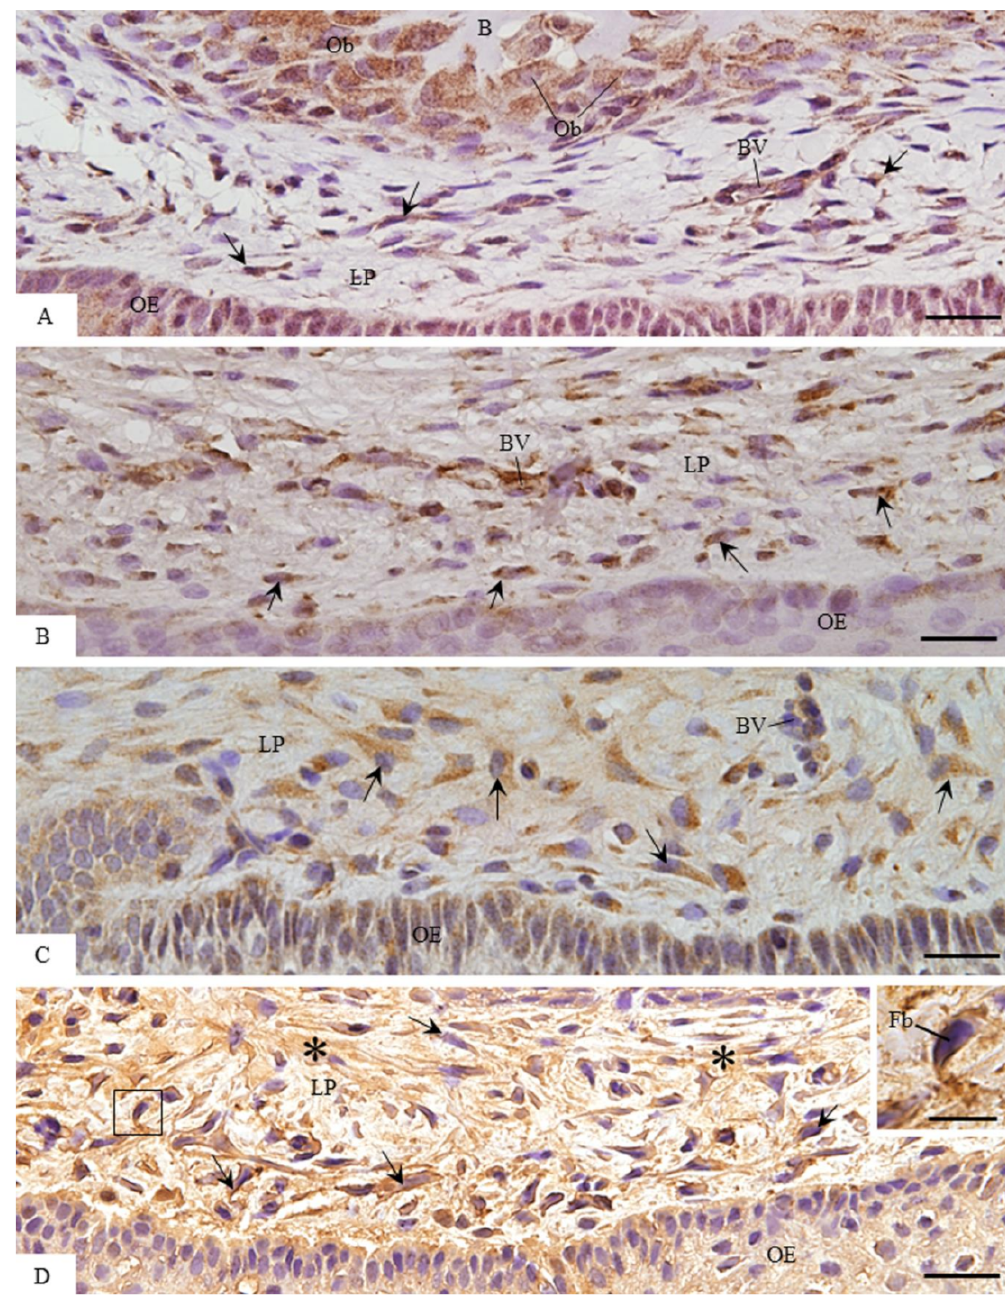
Figure 5. Light micrographs of portions of oral mucosa of the eruptive pathway of first molars of 9- ( A ), 11- ( B ), 13- ( C ), and 16-day-old ( D ) rats. The sections were subjected to the immunohistochemistry for detection of MMP-1 (brown-yellow colour) and counterstained with haematoxylin. Immunolabelled cells (arrows) are observed in the lamina propria (LP) at different stages of tooth eruption. High magnification (inset), outlined area of D , shows immunostained fibroblast cytoplasm (Fb). Note an enhanced immunolabelling in the lamina propria (LP) of 13- and 16-day-old rats ( C and D ); immunolabelling is observed in the extracellular matrix (asterisks). Ob, osteoblasts; B, bone matrix; OE, oral epithelium; BV, blood vessel. Bars: 20 µ m and 6 µ m